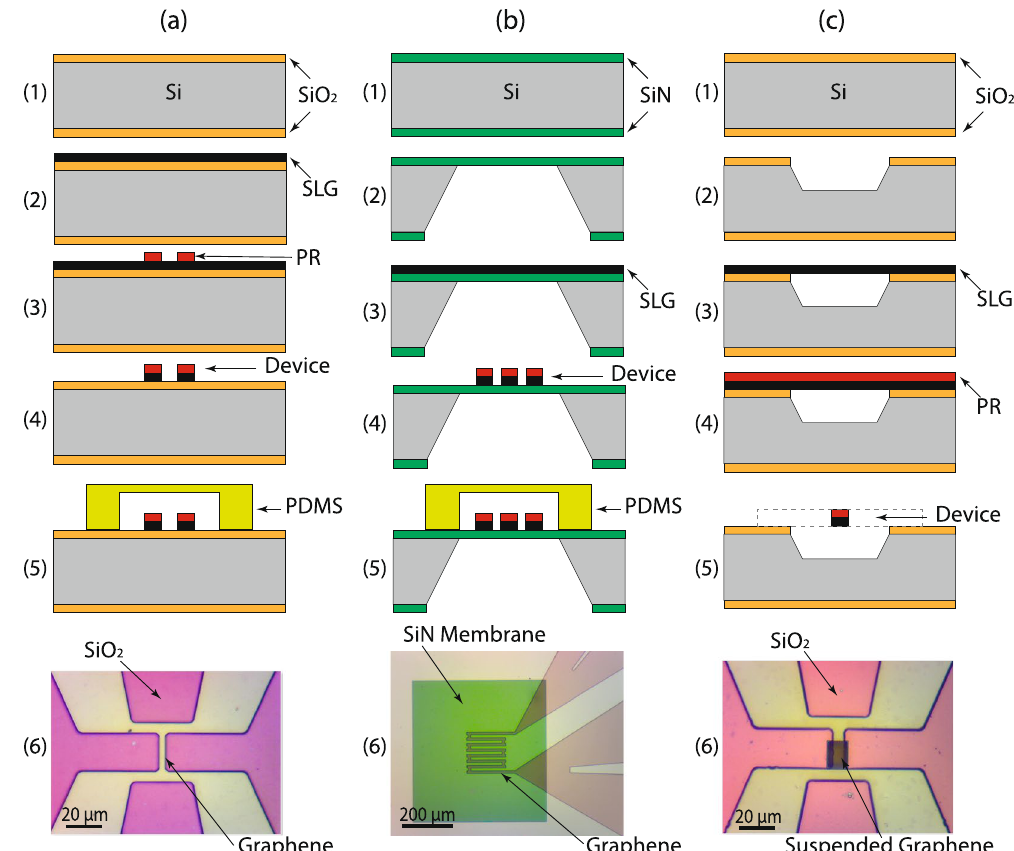
Figure 1. Micro-fabricated SLG temperature sensor devices on three different substrates. ( a ) SiO 2 /Si substrate. Cross-sectional view of the fabrication process flow including: thermal growth of SiO 2 (1), SLG transferring (2), device patterning (3), plasma etching of graphene (4), and (5) PDMS gasket protection of the sensor during PR removal at electrical contacts area. (6) Close-up picture of the completed device with 4-wire electrodes configuration. ( b ) SiN substrate. Cross-sectional view of the fabrication process including: (1) LPCVD SiN deposition, (2) defining membrane using the KOH etching from the backside, (3) SLG transferring, (4) device patterning using O 2 plasma and (5) PDMS gasket protection of the sensor during PR removal at electrical contacts area. (6) Close-up picture of the completed device with the 4-wire electrodes configuration. ( c ) Suspended graphene. Cross-sectional view of the fabrication process flow including (1) thermal growth of the SiO 2 , (2) patterning the suspension pits using BOE etching of SiO 2 followed by KOH etching of Silicon, (3) SLG transferring, (4) spin coating of PR and (5) device patterning using O 2 plasma. (6) Close-up picture of the completed device with the 4-wire electrodes